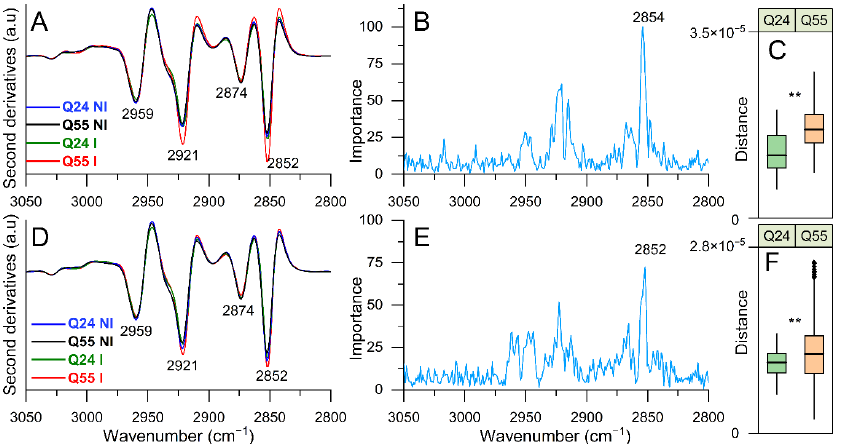
Figure 5. FTIR analysis of lipid modifications investigated in the 3050–2800 cm − 1 CH n stretching range. The second derivatives of representative FTIR spectra, identified by PLS-DA, of E. coli cells expressing ATX3-Q24 and ATX3-Q55 at 5 ( A ) and 8 ( D ) hours of induction, and of NI cells are reported. In ( B ) (5 h) and ( E ) (8 h), the loading plots representing the spectral components more relevant for the discrimination between the classes are displayed. In ( C ) (5 h) and ( F ) (8 h), the distribution of distances between I and NI is represented as box plots, as in Figure 4. The reported spectroscopic analyses